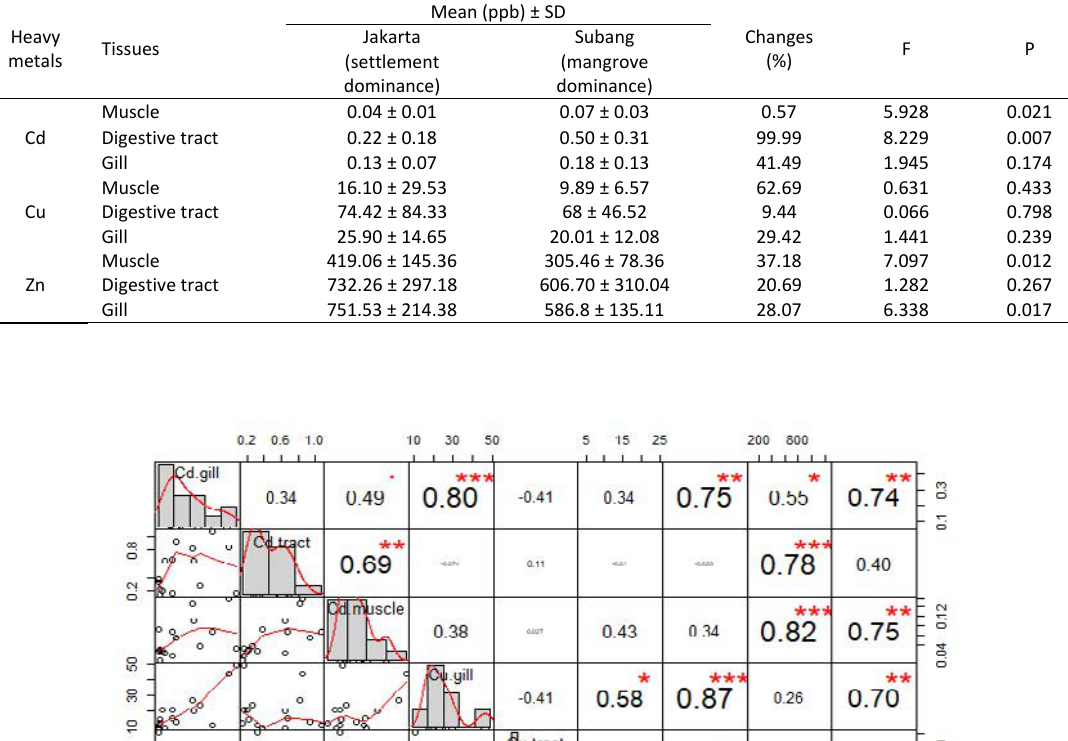
Table 1: Summary of the Cd, Cu, and Zn mean ± standard deviation (SD) (ppb) and ANOVA in gills, digestive tracts, and muscle of P. argentata related to land uses in Jakarta in the west (settlement dominance) and Subang in the east (mangrove dominance) in West Java coast, Indonesia